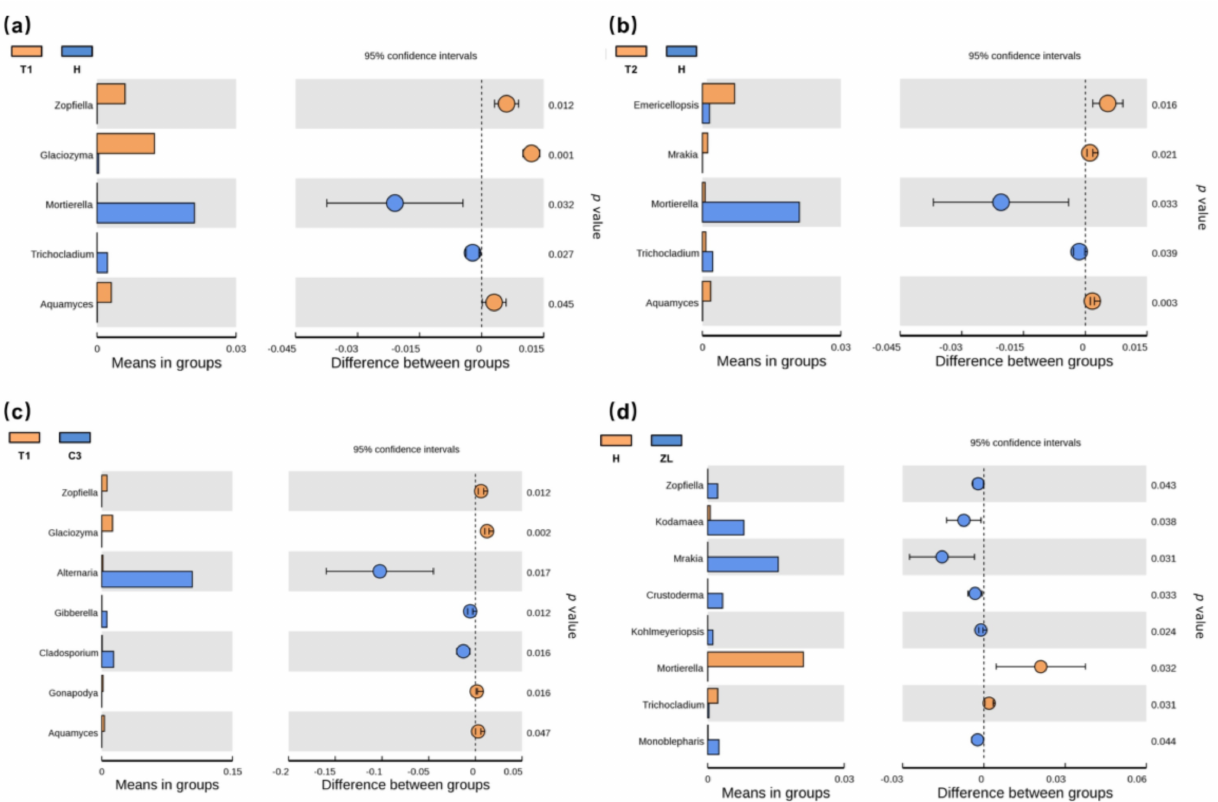
Figure 6. A comparison of the relative abundance of two soil fungal groups between natural and degraded Carex wetlands at the level of fungal genera. ( a ) comparison between T1 and H sites; ( b ) comparison between T2 and H sites; ( c ) comparison between T1 and C3 sites; ( d ) comparison between H and ZL sites. The significance of differences between the two groups was determined by a t -test with 95% confidence